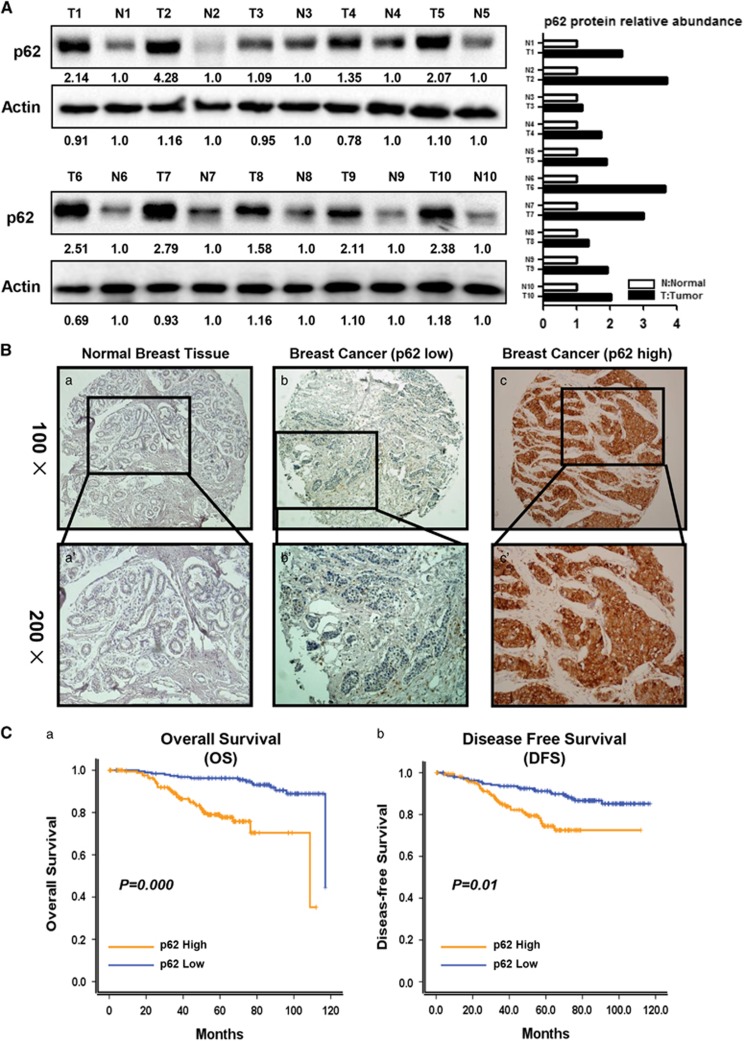
High p62 expression levels indicate poor clinical outcome in breast cancer patients. (A) Ten pairs of breast tumors (T) and adjacent normal tissues (N) were subjected to western blot analysis. Fold of p62 expression was normalized to adjacent normal tissue in each pair. (B) Representative images of negative, low and high levels of p62 staining, which showed no, few and much visible cellular brown-yellowish granules, respectively (a–c, × 100). The indicated fields of (a–c) are magnified to show the clear staining granules (a'–c', × 200). (C) Cumulative survival probabilities (a, OS and b, DFS) were calculated through the Kaplan–Meier method (n=369) based on p62 expression. Survival rates were compared by log-rank test.